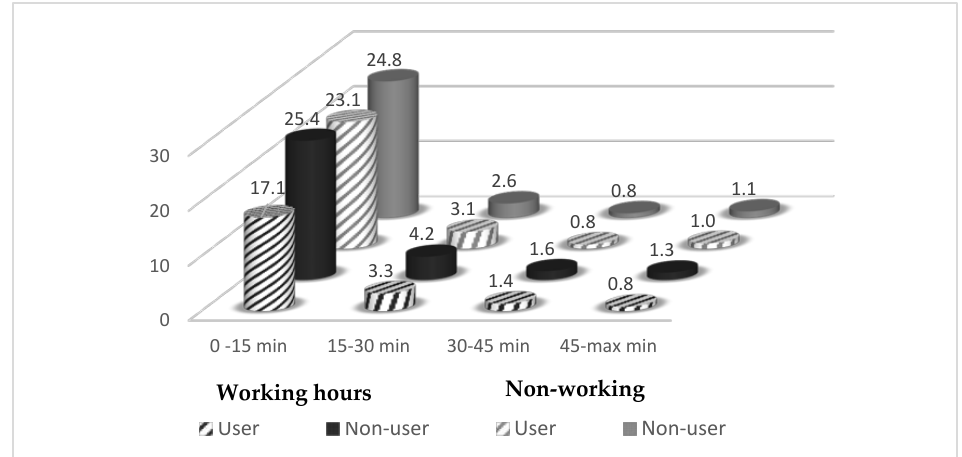
Figure 1. Number of sitting bouts of different durations for users and non-users during working and non-working hours.